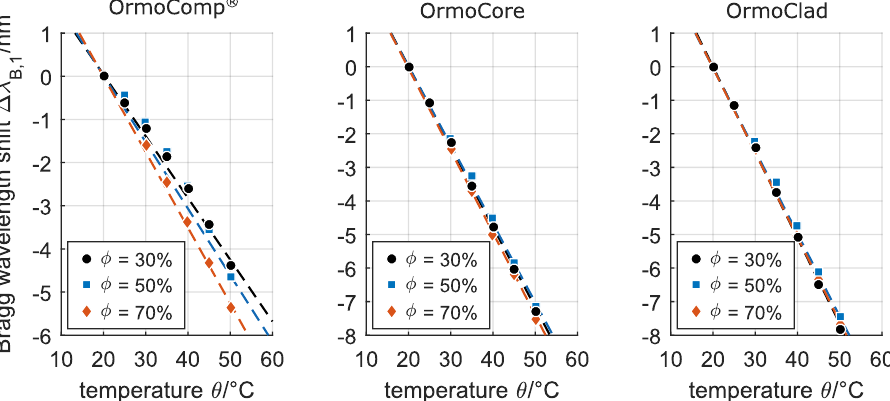
Figure 5. Linear dependence of the buried channel waveguide Bragg gratings in OrmoComp ® , OrmoCore, and OrmoClad on the temperature for a relative humidity φ of 30%, 50%, and 70%.